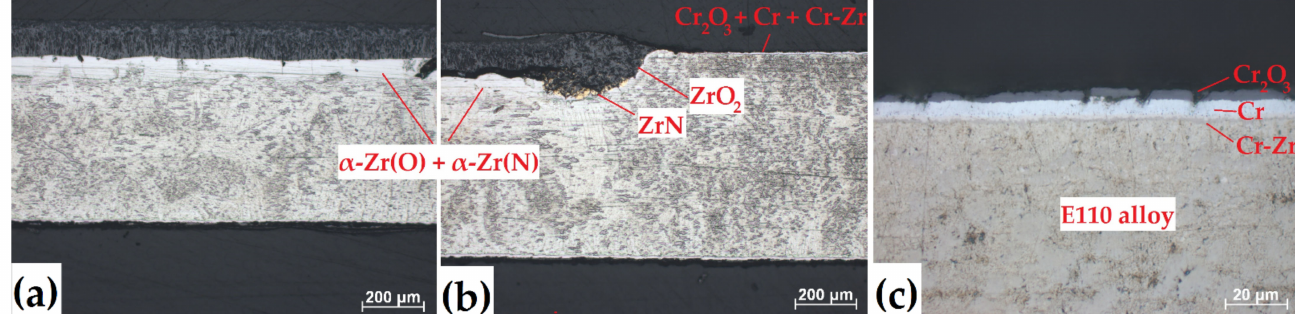
Figure 7. Optical images of cross-section microstructures of the ( a ) uncoated, ( b ) partially and ( c ) fully Cr-coated samples in the region of cladding tube after oxidation at 1100 ◦ C for 30 min.